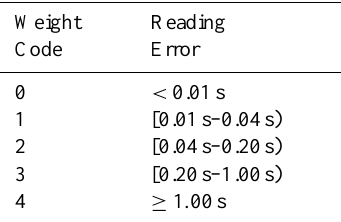
Table A1. Weighting scheme adopted in the preliminary locations performed by using Hypo71 (Lee and Lahr,